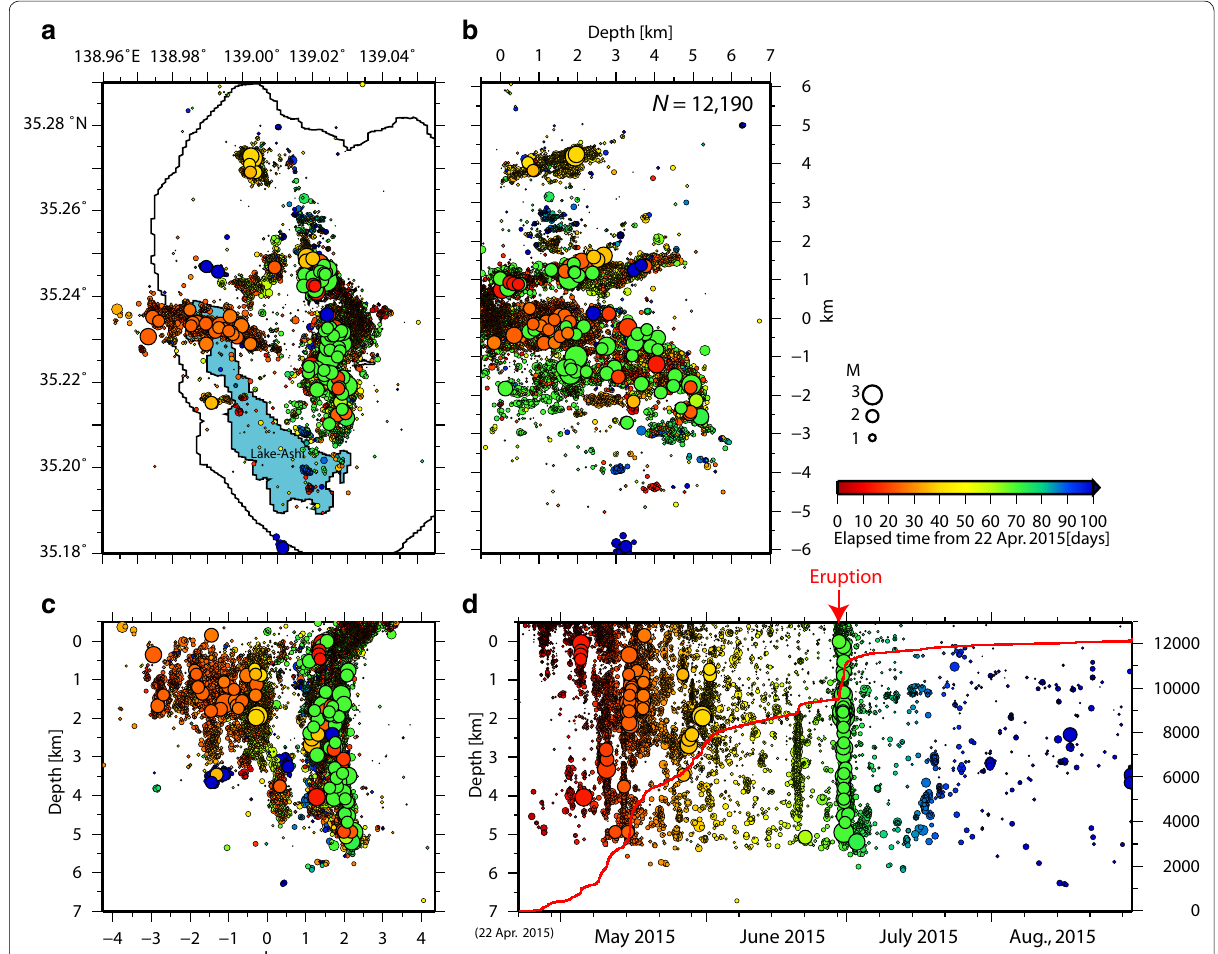
Fig. 2 Hypocenter distribution of VT earthquakes that occurred from April 22 to August 31, 2015. a Epicentral distribution, b depth distribution along the N–S section, c depth distribution along the E–W section, d time-depth distribution. The red line indicates the cumulative number of VT earthquakes. The color of each circle indicates the time elapsed from April 22,